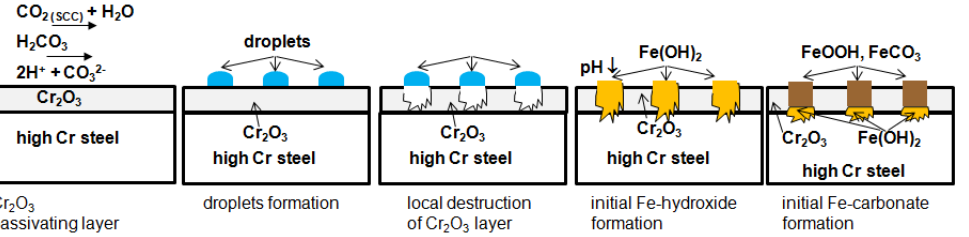
Figure 11. Schematic cross-section illustration of the second step of the corrosion procedure to form the leopard structured corrosion scale consisting of siderite FeCO 3 and goethite FeOOH on 16–17% Cr high alloyed stainless steels X35CrMo17 and X5CrNi CuNb16-4.